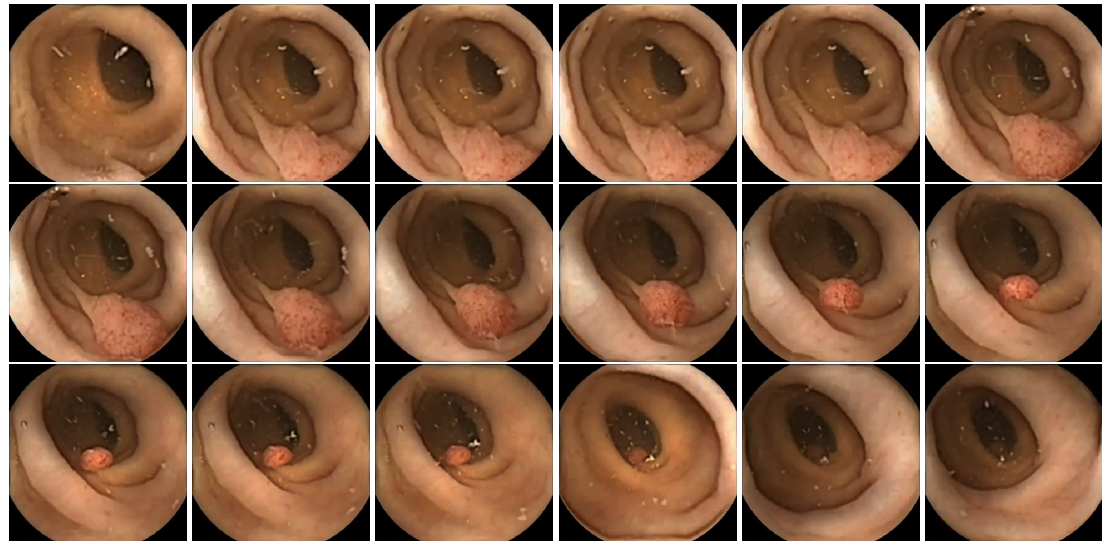
Figure 3. Shapes of polyps vary across different frames, within a single patient VCE exam, due to the unconstrained movement of the camera. ( top row): data from PillCam R (cid:13) COLON 2 polyps occurring in consecutive neighboring frames (#117 to 122); ( bottom two rows): other frames (#123, 128, 133, 138, 143, 148, and 153, 158, 163, 168, 173, 178) from the polyp sequence where the shape and color undergo